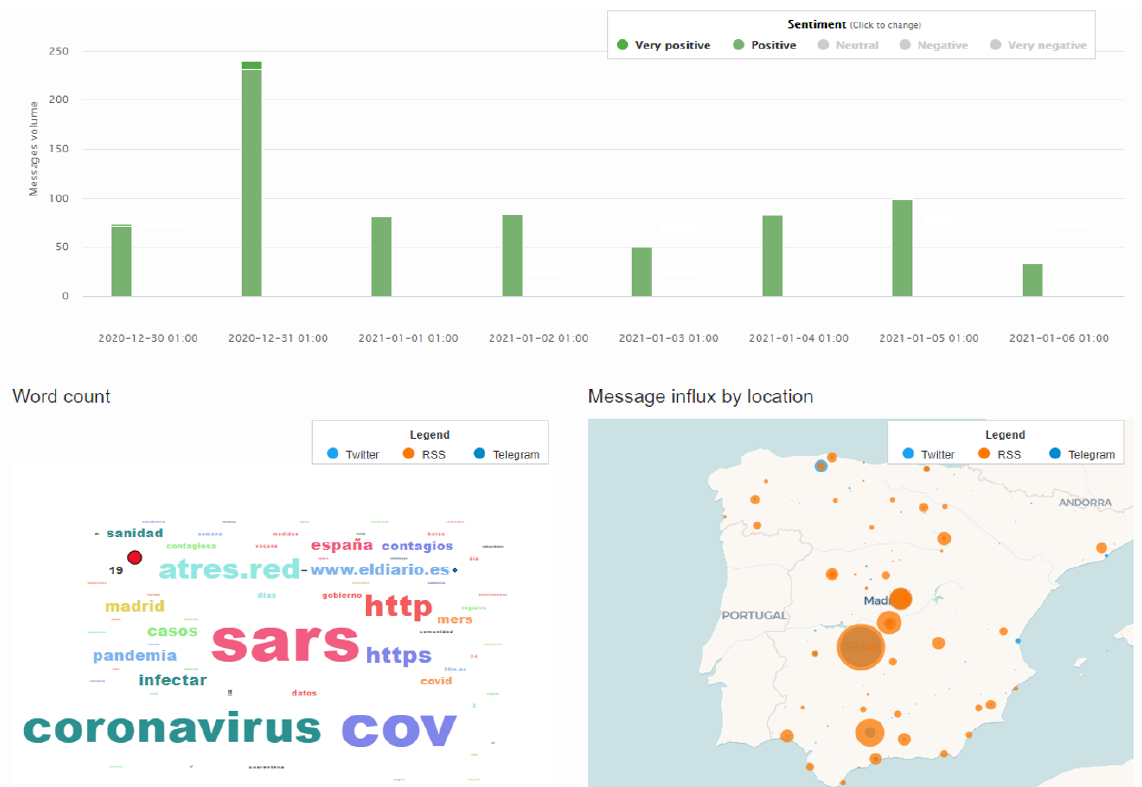
Figure 4. Example of geolocation visualisation considering the dates from 30 December 2020 to 6 January